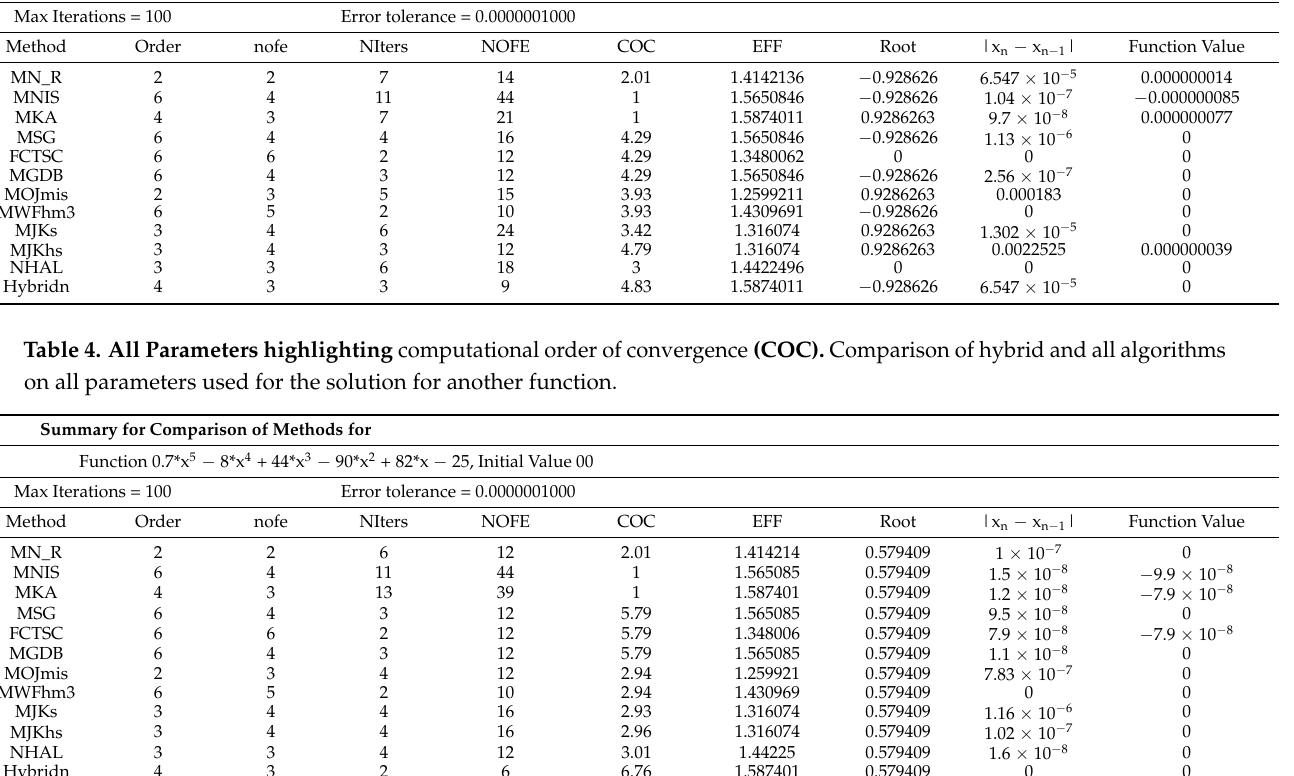
Table 5. All Parameters highlighting efficiency index (EFF). Comparison of hybrid and all algorithms on all parameters used for the solution for another different function. Summary for Comparison of Methods for Function x 3 + log(x), Initial value